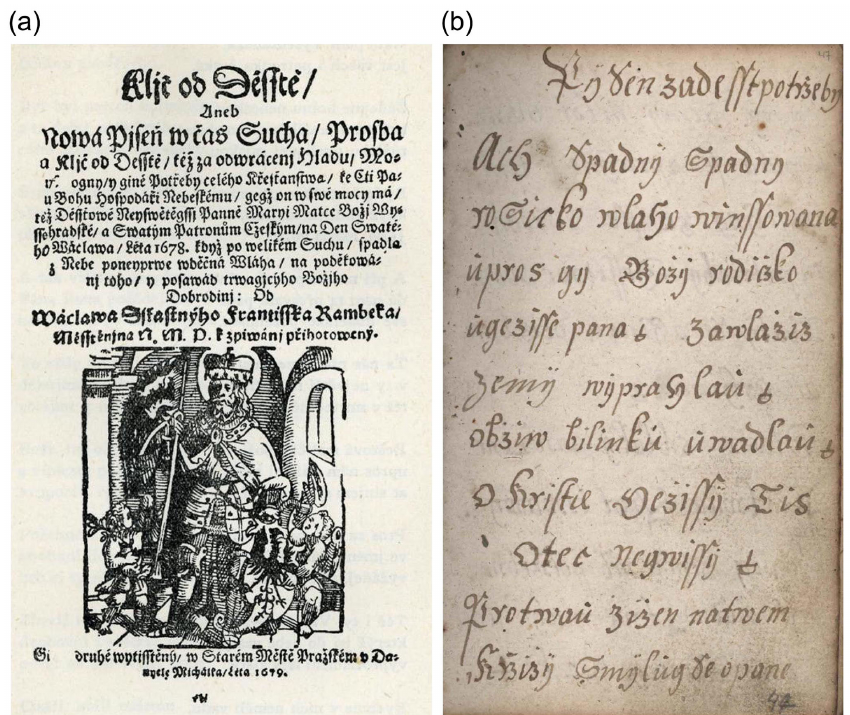
Figure 2. (a) Title page of “Key to the Rain, or a New Song for a Time of Drought”, second edition, published in Prague in 1679 (AS4); (b) introductory page of “Song in Need of Rain” from manuscript records of Antonín Štˇepán, a citizen of Pelhˇrimov (Martínková,